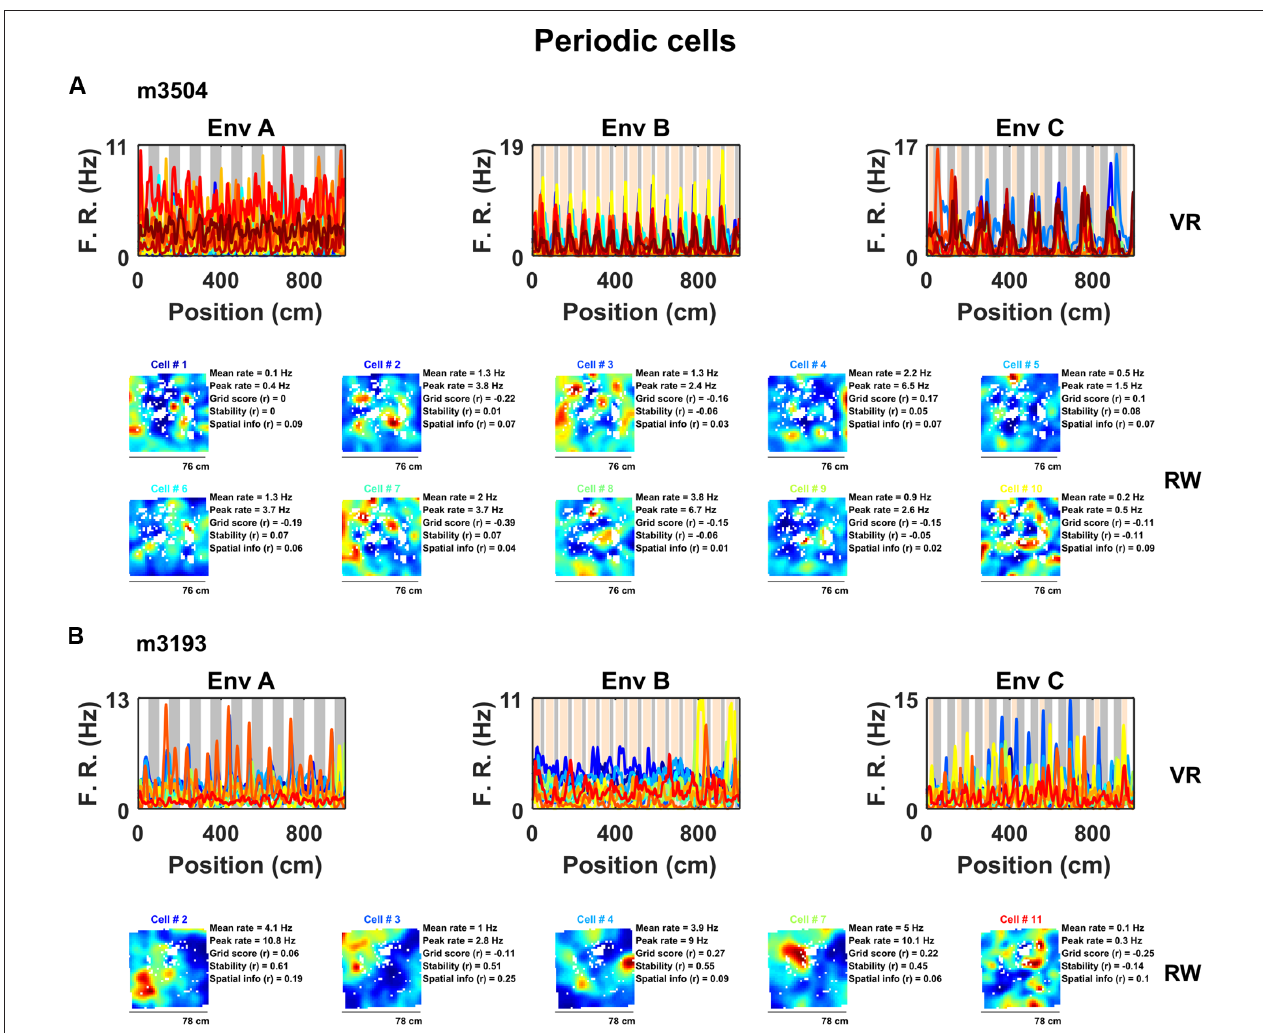
FIGURE 2 | A sub-population of non-grid cells exhibit pronounced spatial periodicity in 1D VR environments. Examples of co-recorded non-grid periodic cells from two animals ( A , 10 cells from mouse m3504: B , five cells from mouse 3193) shown as ratemaps in both VR ( top row ) and RW ( bottom rows ). In VR, the firing rate of cells is plotted against position in each environment (A–C) with the periodicity of repeating cues indicated in the background (gray and orange). In RW the ratemaps of the same color-coded cells in VR are shown together with mean and peak firing rate, grid score, stability, and spatial information. Despite the regularity of the firing pattern patterns in VR, these cells neither showed clear grid-like firing pattern nor spatial firing of any kind in